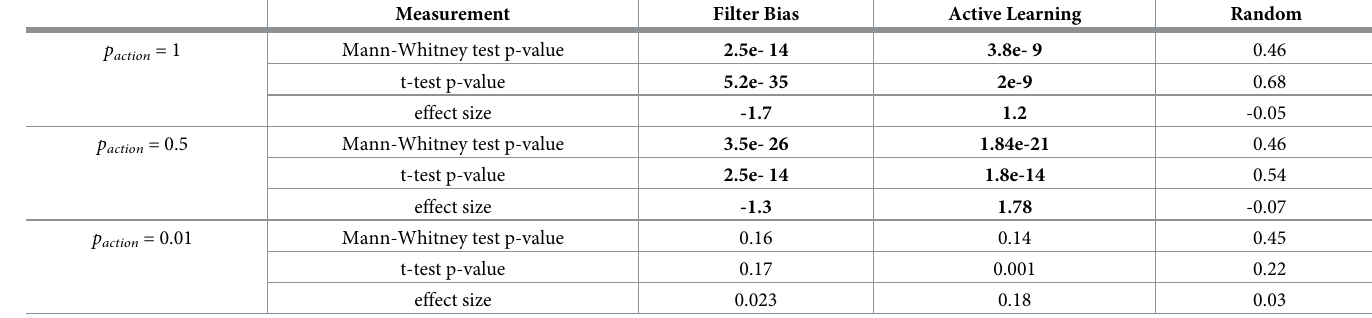
Table 7. Results of the Mann-Whitney U test and t-test for the inequality of the computed three forms of iterated algorithmic bias based on the different probability levels of human action. Here, effect size is computed as ES = ( Gini | t = 0 − Gini | t = 200 )/ standard . dev . Bold means the significance at p < 0.05. The more the human reacts to the system, the bigger is the inequality in the